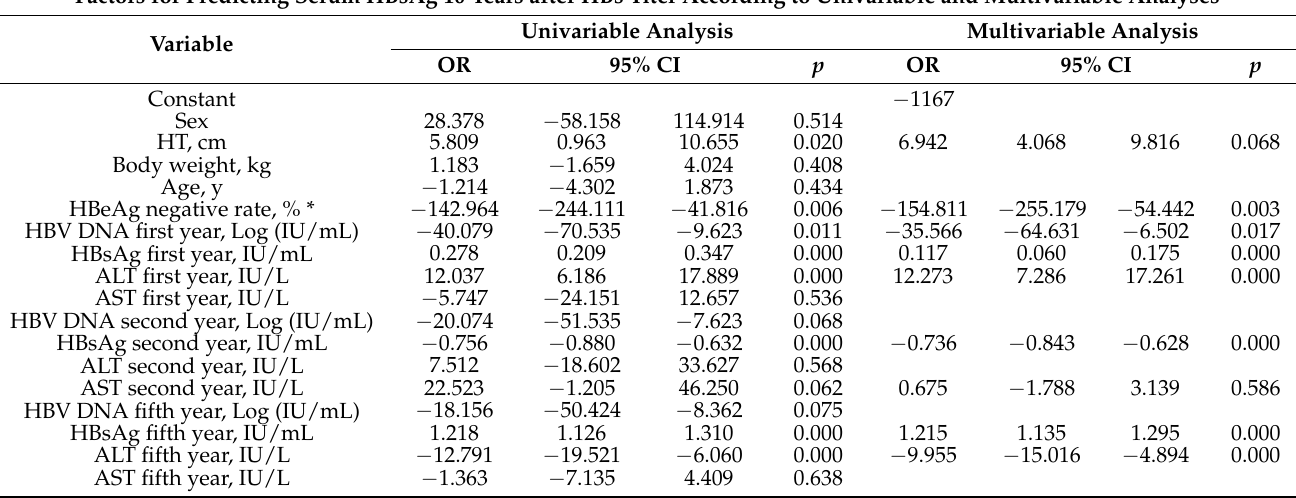
Table 2. Variables that were included in the logistic regression